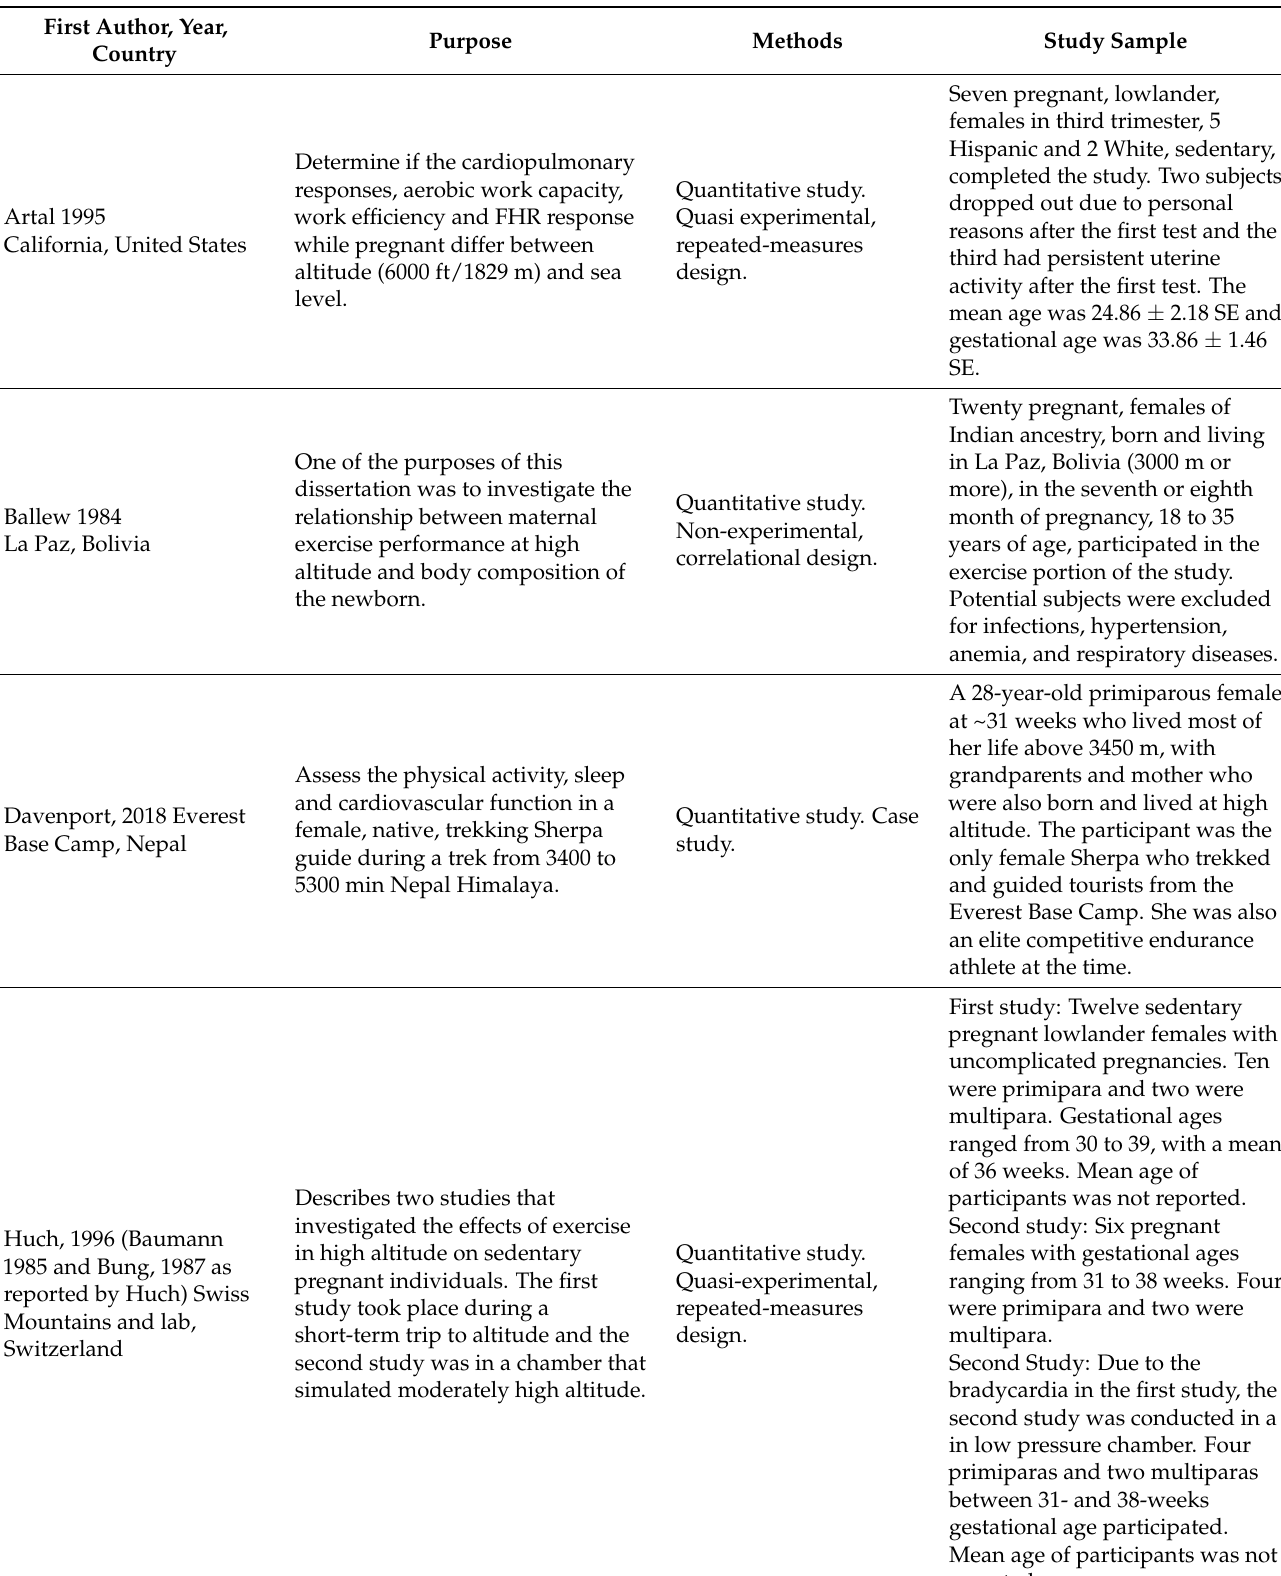
Table A1. Summary of studies regarding the effects of exercise at altitude during pregnancy (Part